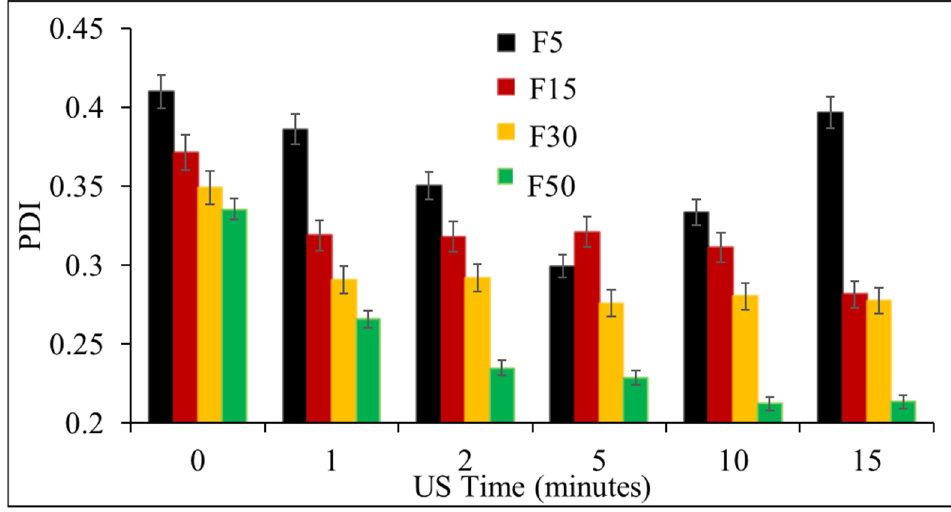
Figure 4. Effect of US time on PDI of blank NLCs.